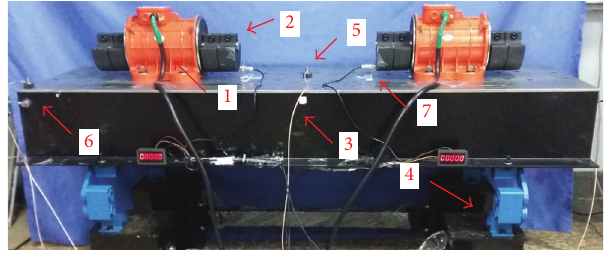
Figure 8: Experiment equipment ( 𝑟 𝜓 ≈ 0.6